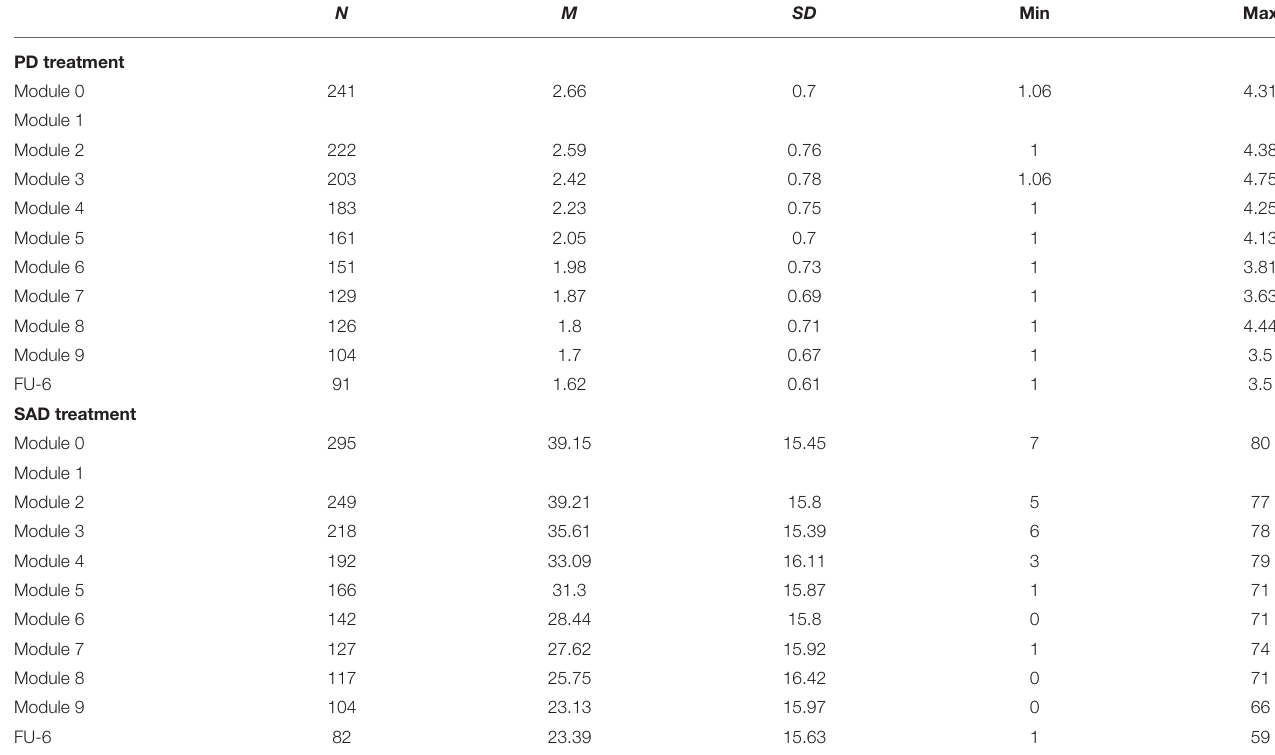
TABLE 3 | Descriptive data of anxiety symptom levels throughout the treatment. N M SD Min